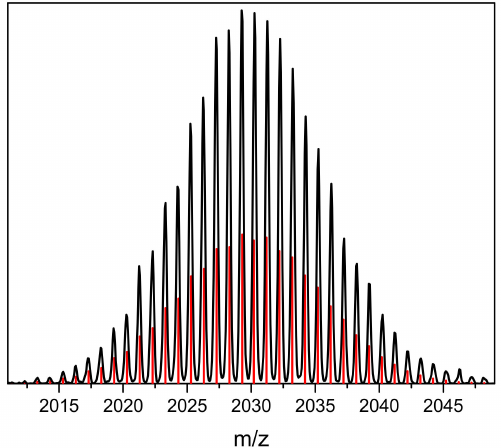
Figure 1. Selected area of the ESI-MS spectrum obtained by examination of a thf solution of compound 1 . The mass spectrum was acquired in positive ion mode (4500 V, 300 ◦ C), monitoring 1 with an additionally attached [Cu-NHC] + moiety at m / z 2029.3 [(NHC Dipp Cu) 2 { η 3 -Ge 9 (Si( i Pr) 3 ) 3 }] + . The calculated pattern with the characteristic isotope distribution is shown below as red